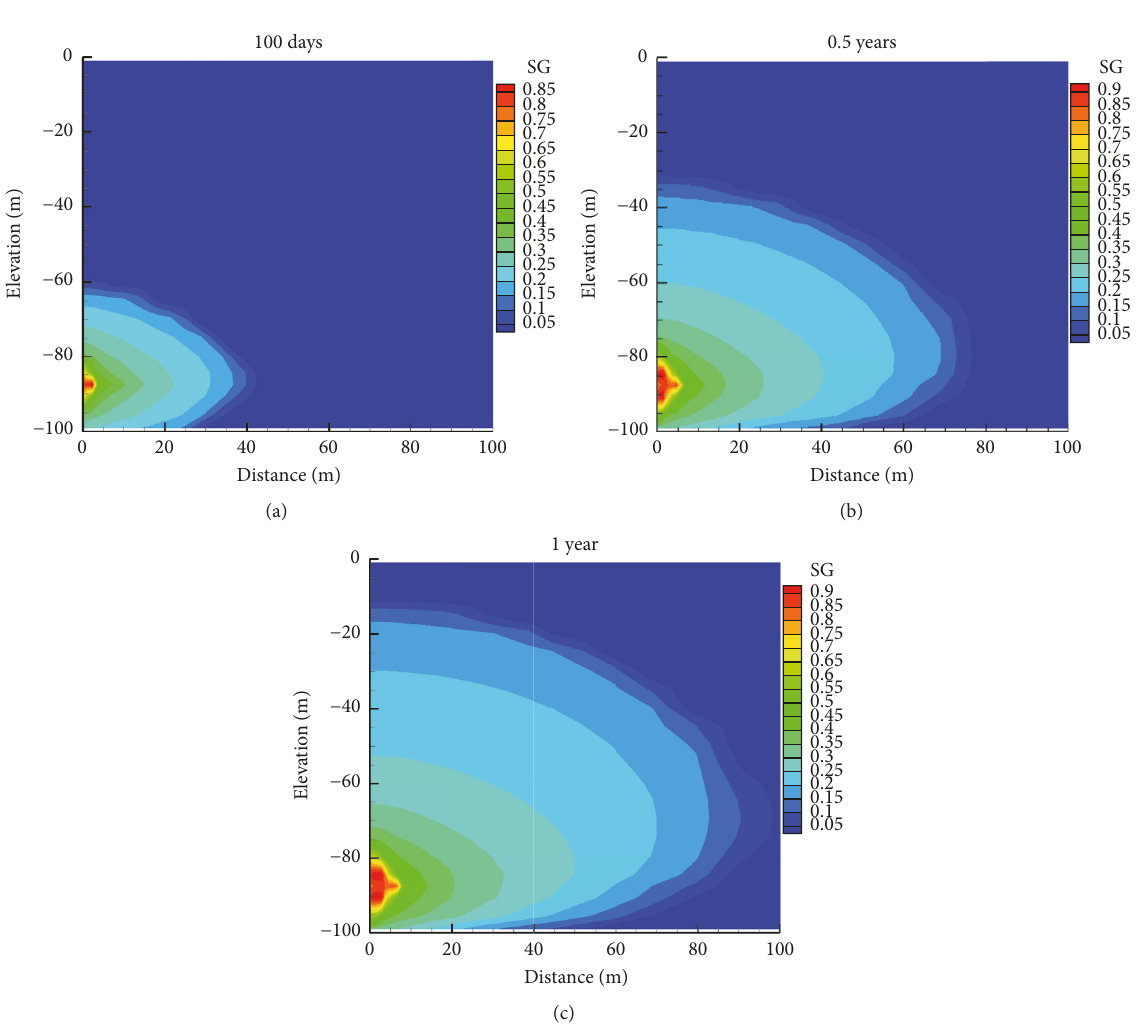
Figure 8: Contour map of gas saturation ( 𝑆 𝑔 ) near the injection well (gas saturation ( 𝑆 𝑔 ) is observed in the range of 0 to 100m, (a) after 100 days of CO 2 injection, (b) after half a year of CO 2 injection, and (c) after one year of CO 2